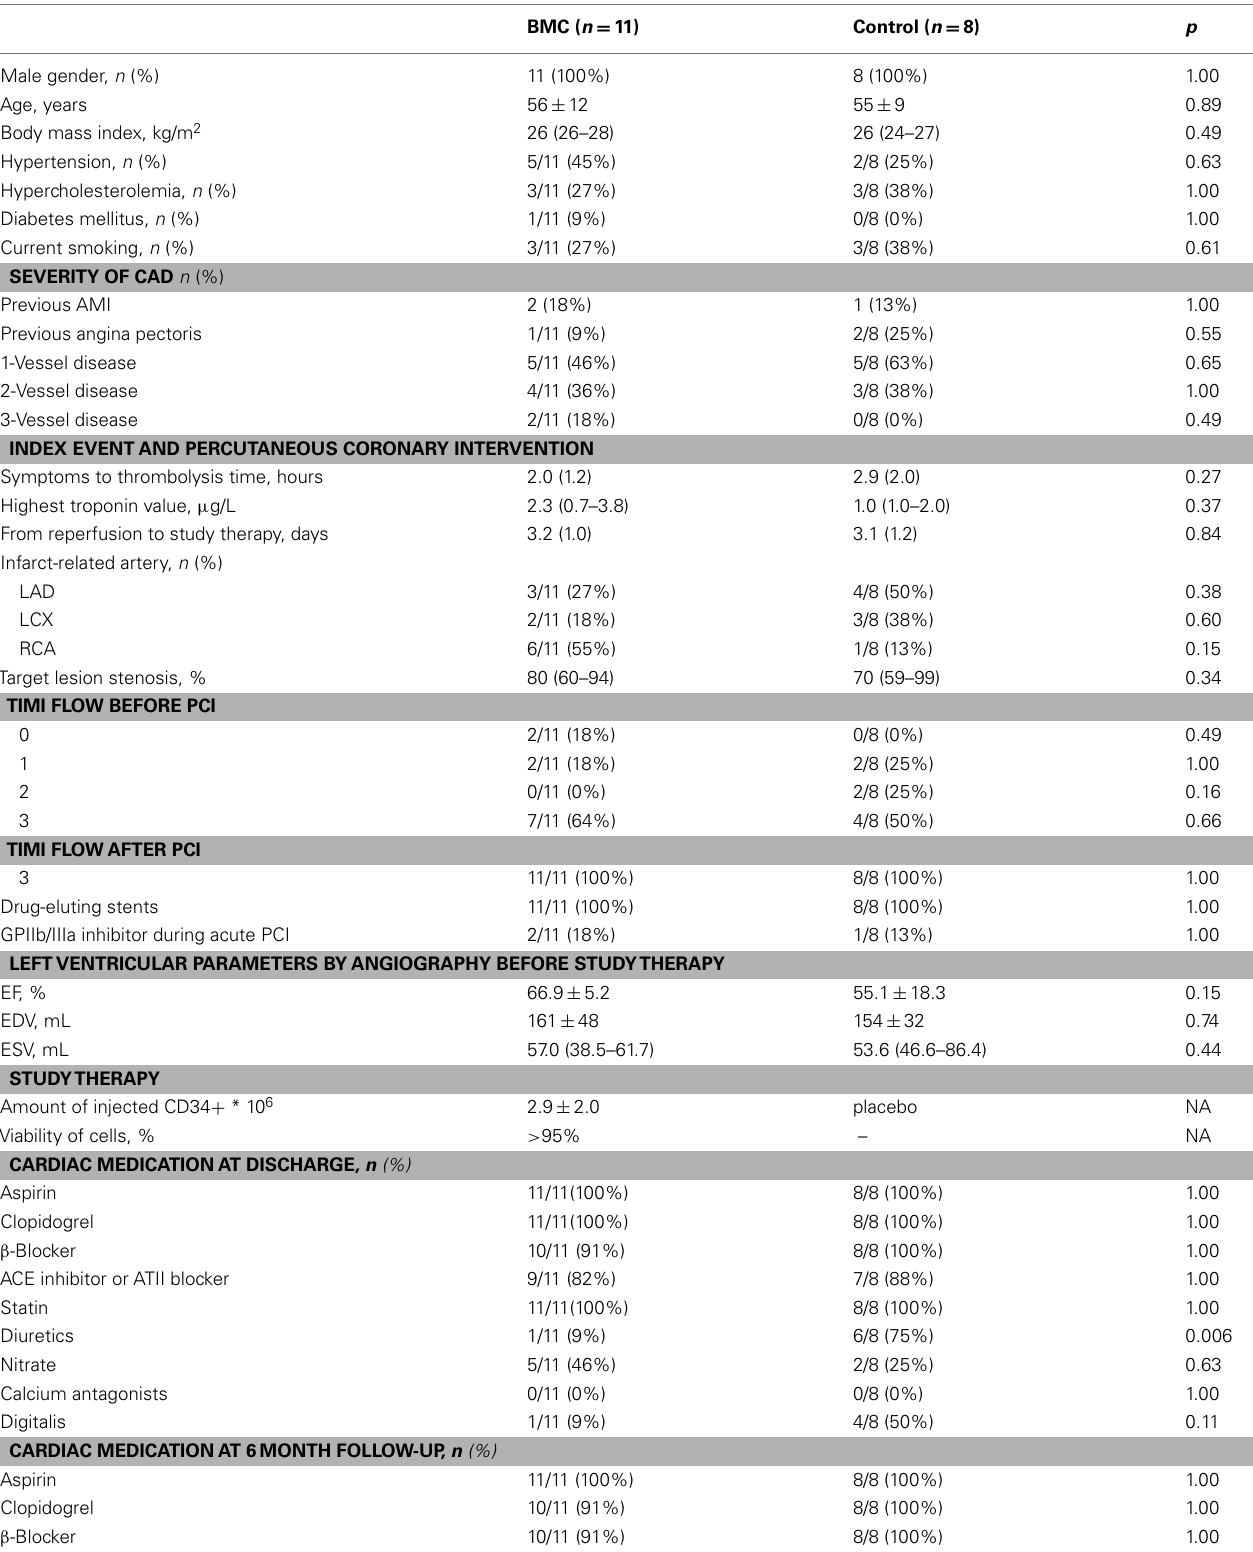
Table 1 | Characteristics of the